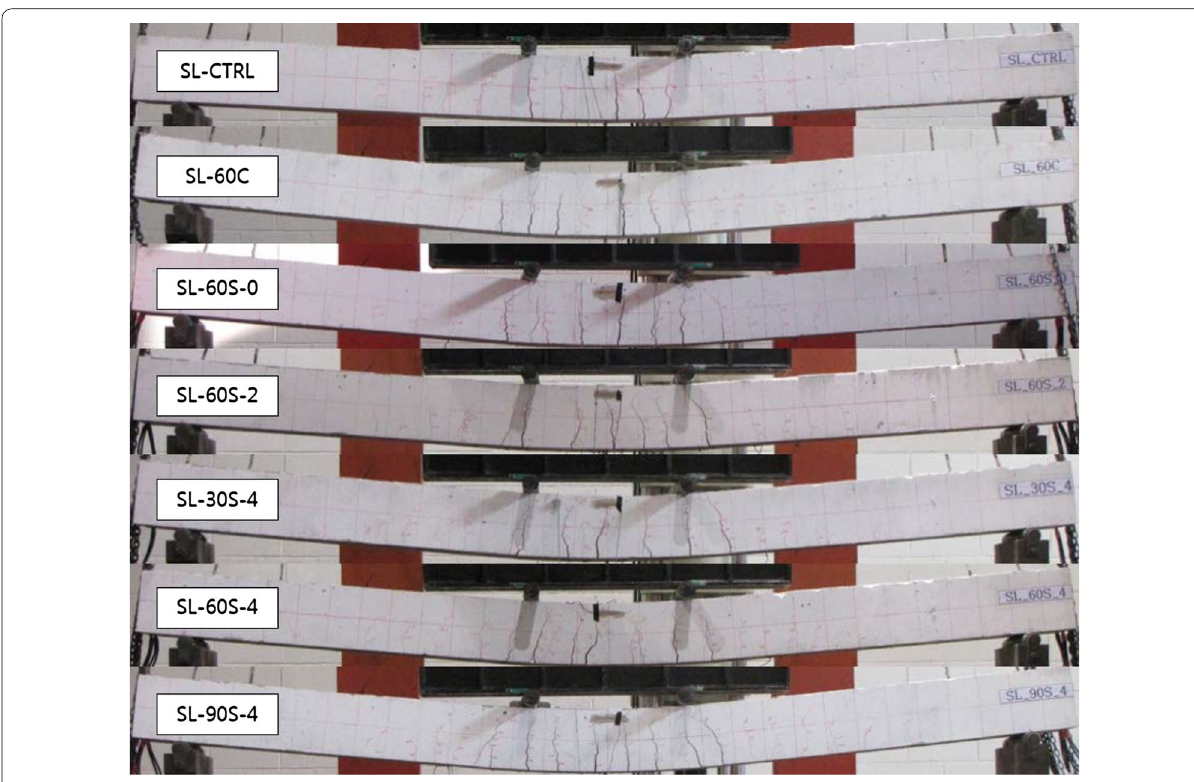
Fig. 12 Flexural failures with crack patterns.